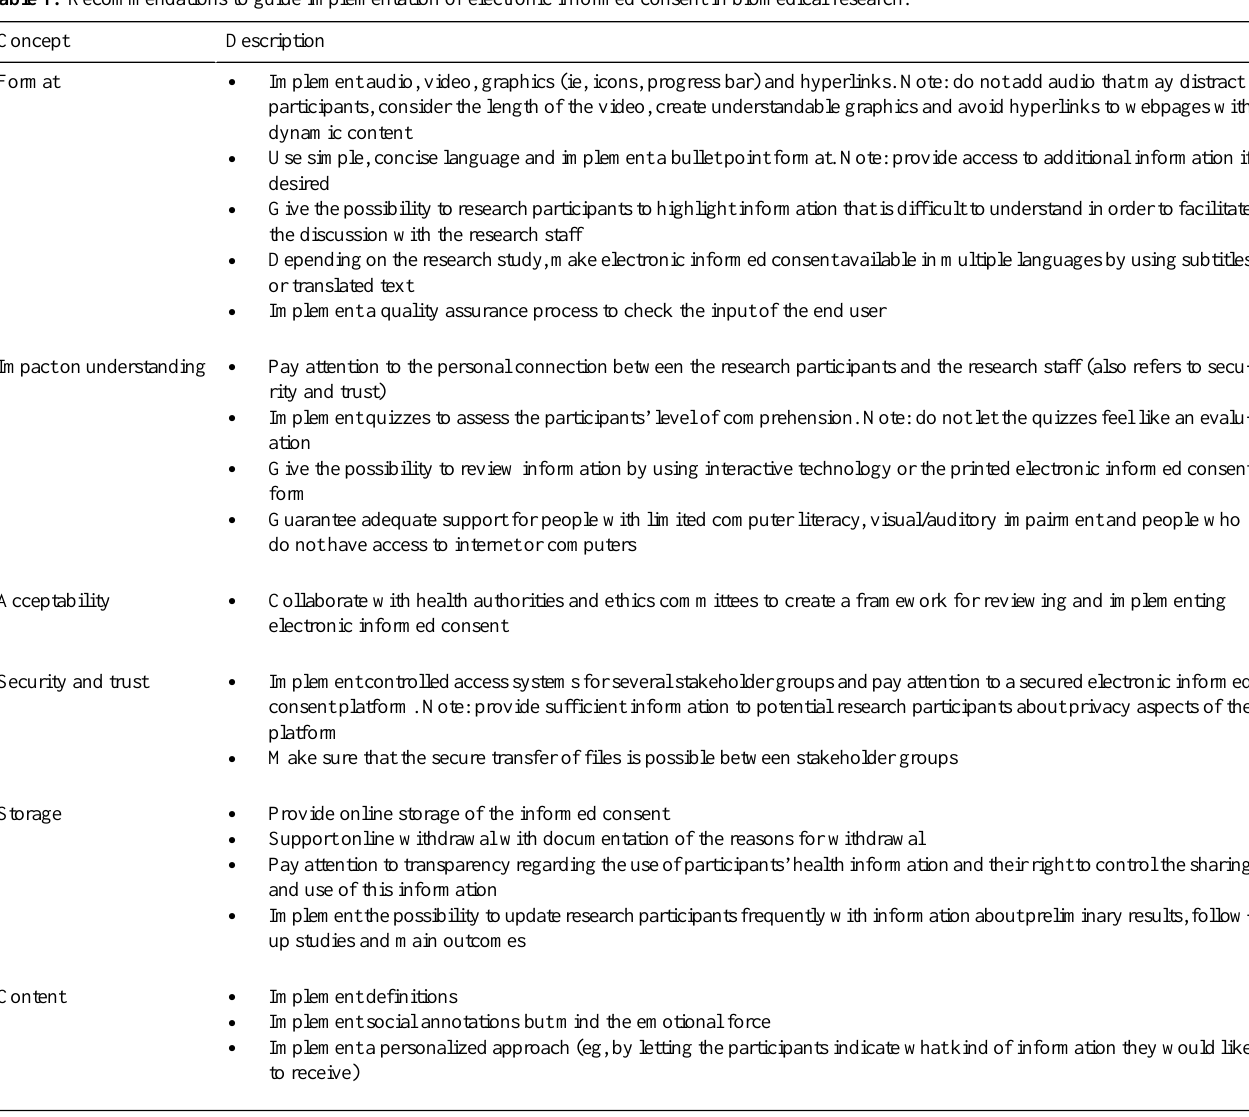
Table 1. Recommendations to guide implementation of electronic informed consent in biomedical research.